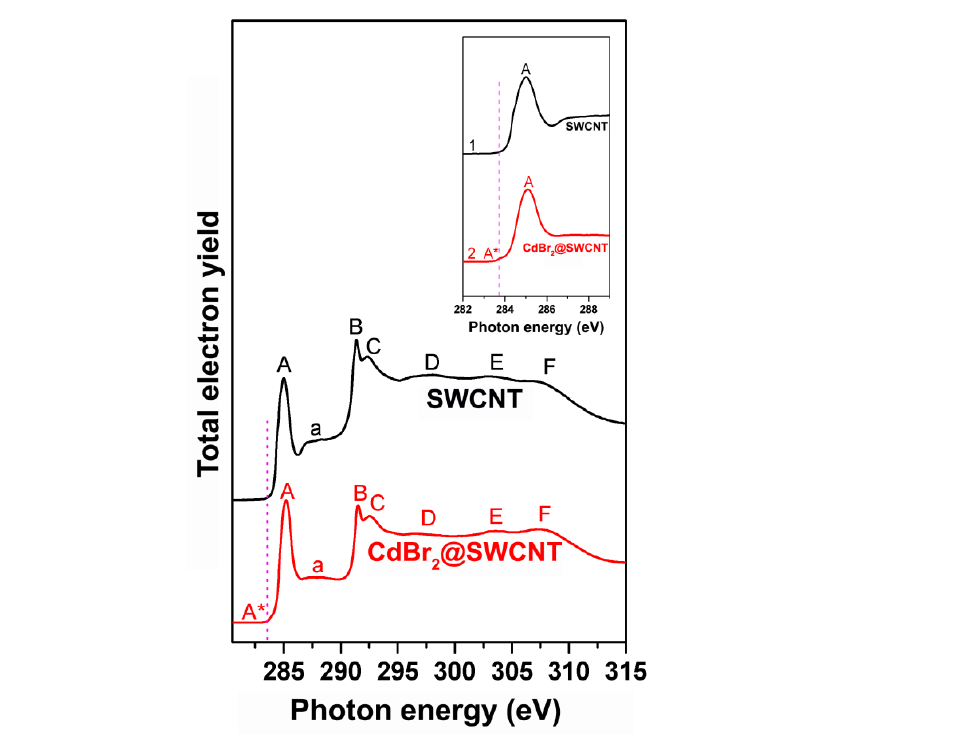
Figure 9. The C 1s NEXAFS spectra of the pristine SWCNTs and nanotubes filled with cadmium bromide. The inset zooms in the π *-resonance. The dashed vertical line marks the new feature A*. Reprinted by permission from [16]: SpringerNature, Journal of Materials Science, Kharlamova et al. Charge transfer in single-walled carbon nanotubes filled with cadmium halogenides, copyright 2013. Table 4. The summary of doping-induced modifications of the C 1s NEXAFS spectra of filled SWCNTs. Observed Modification of the C 1s NEXAFS